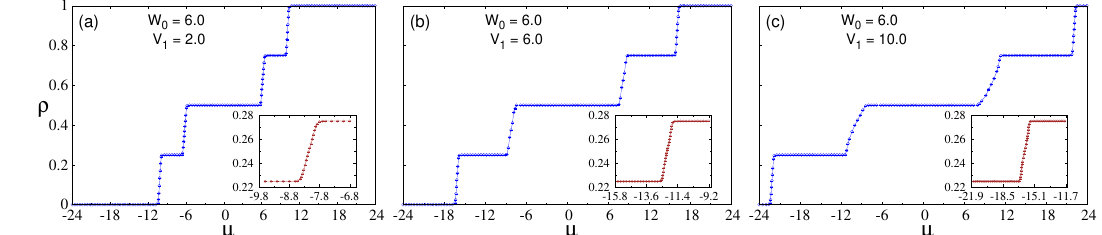
Figure 10: Variations of density versus chemical potential for three different values of = 6.0. The blue curves show NN repulsion V , with the on-site potential strength W 1 0 the ρ − µ variations for a 20 × 20 honeycomb lattice with periodic boundary condi- tions. The brown curves in the insets display the splitting of the ρ = 1 / 4 insulator under open boundary condition along x